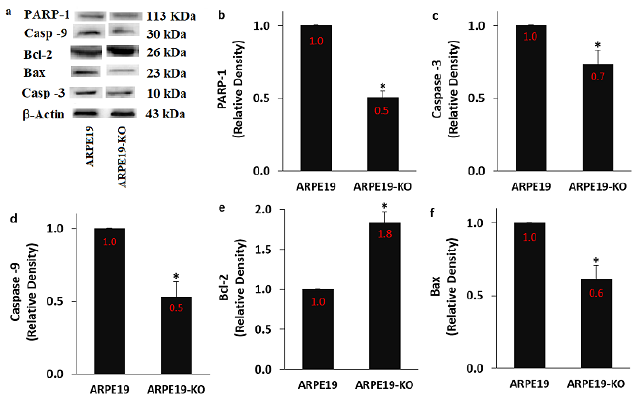
Figure 9. The regulator role of TSPO deletion on the protein expressions of PARP-1, caspase-3 (Casp -3), caspase -9 (Casp -9), Bcl-2, and Bax. (Mean ± SD and n = 3). The band expressions of PARP-1, Casp -3, Casp -9, Bcl-2 and Bax were determined by standard method of Western blot. The proteins of β -actin were used as control. ( a ). Western blot bands. The mean values of PARP-1 ( b ), Casp -3 ( c ), Casp -9 ( d ), Bcl-2 ( e ) and Bax ( f ) were indicated in the Figure 8 by columns. (* p ≤ 0.05 vs. ARPE19).